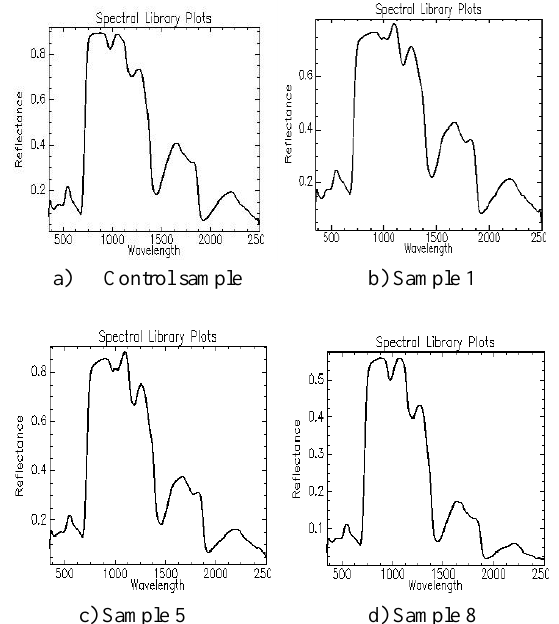
Figure 6. Comparison of spectral profiles for the 1 st and 5 th and control